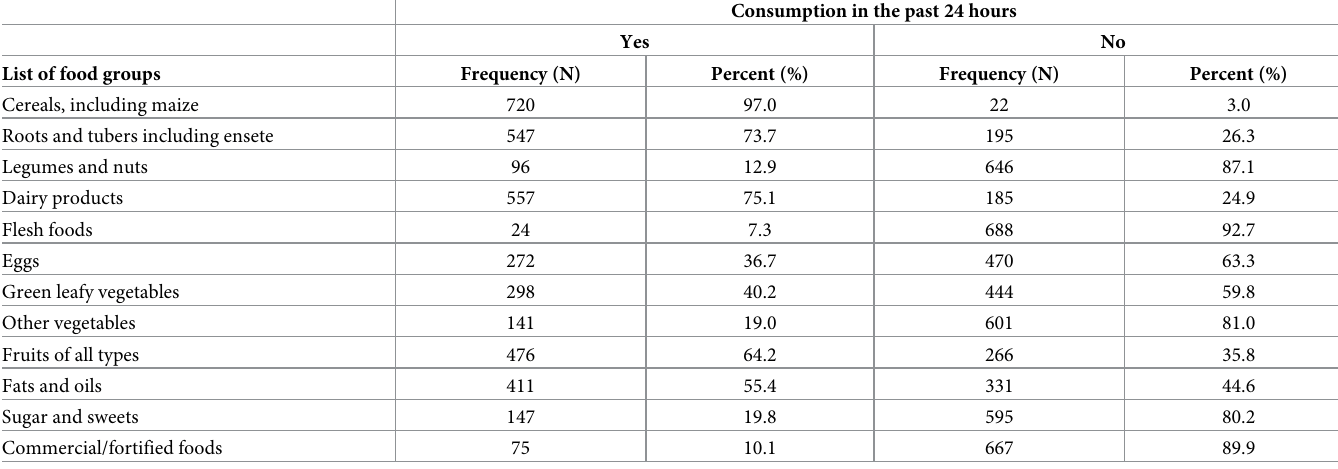
Consumption in the past 24 hours